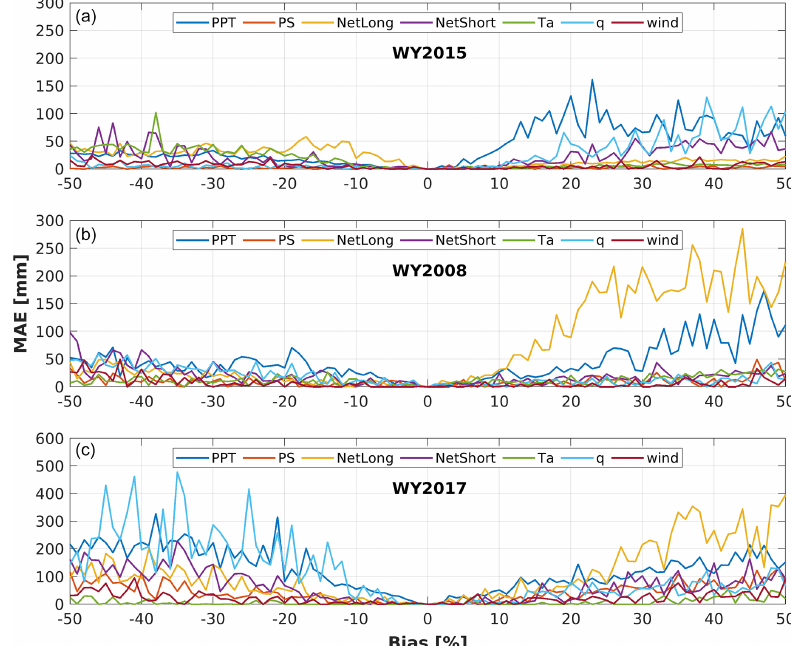
Figure 9. Changes of MAE (mm; relative to no bias) of the inferred 1 April SWE in WY2015 (dry year; first row), WY2008 (normal year; second row) and WY2017 (wet year; third row) with biases perturbed in the meteorological forcings of the training datasets. The limit of the y -axis scale in the WY2015 panel is smaller than that of WY2008 and WY2017 to make the small MAE in WY2015